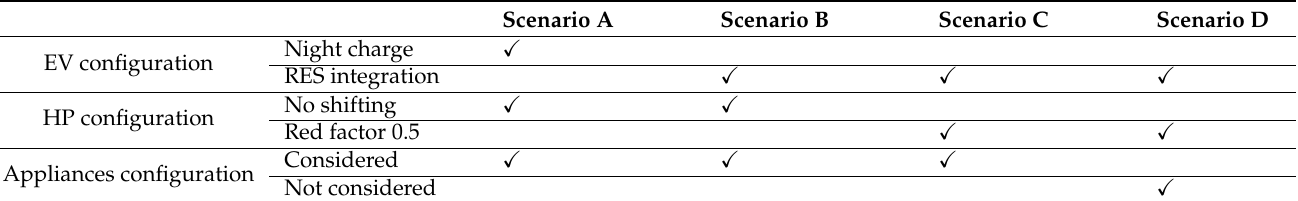
Table 1. The considered scenarios for NPV optimization have been summarized in this table.